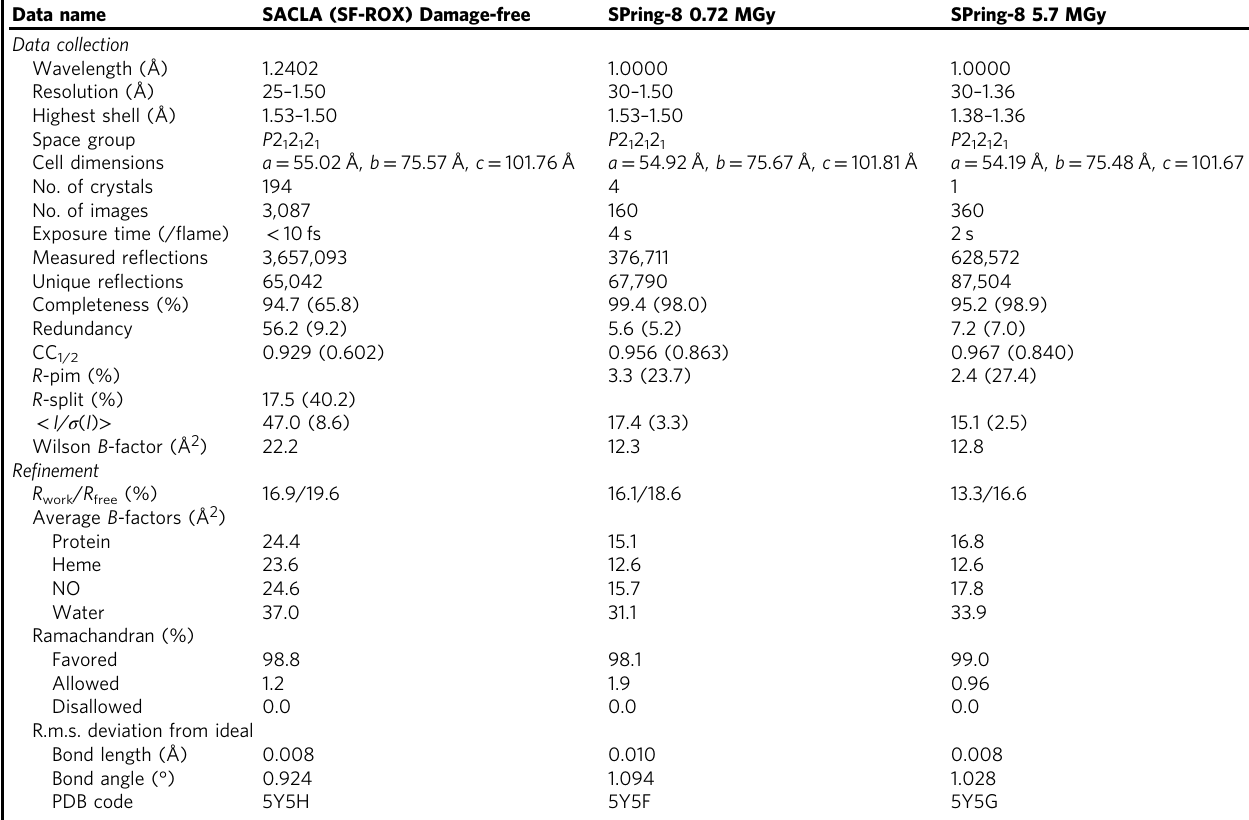
Table 3 Statistics for SF-ROX and SR intensity data collection and structure re fi nement Data